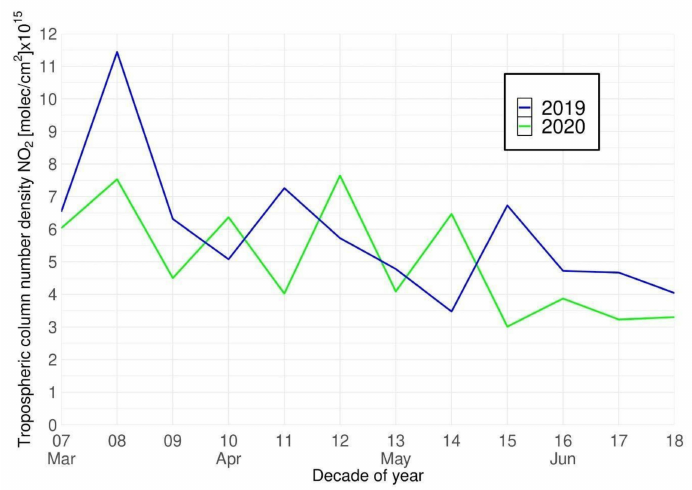
Figure 14. Decade variability of median NO 2 TVCD (molec/cm 2 · 10 15 ) in Warsaw in 2020 (green) and 2019